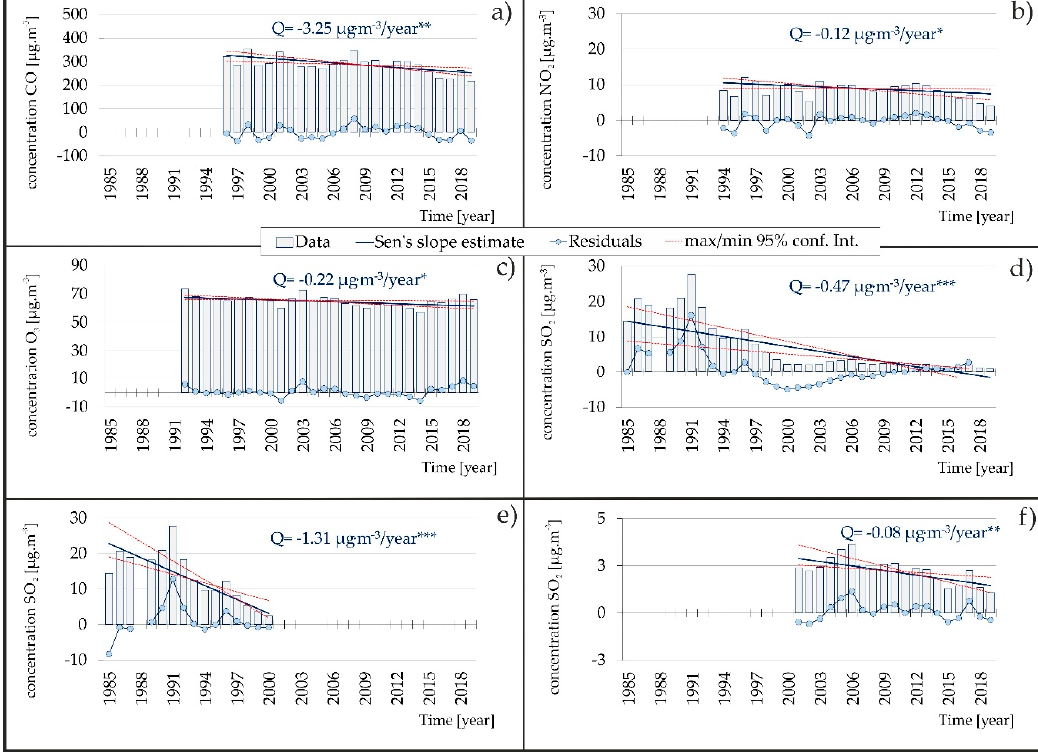
Figure 3. Results of Mann – Kendal test for gaseous pollutants; ( a ) CO, ( b ) NO 2 , ( c ) O 3 , ( d ) SO 2 1985 – 2018, ( e ) SO 2 1985 – 2000, ( f ) SO 2 2001 – 2018.